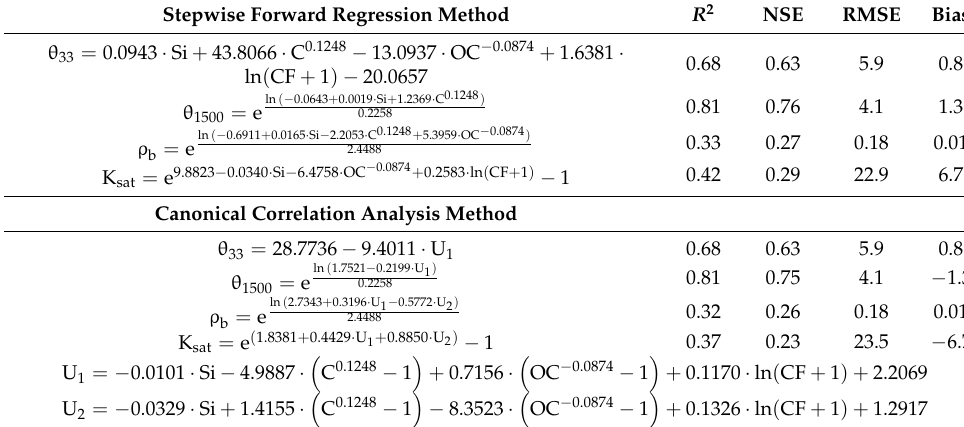
Table A2. PTFs developed for the B Horizon.